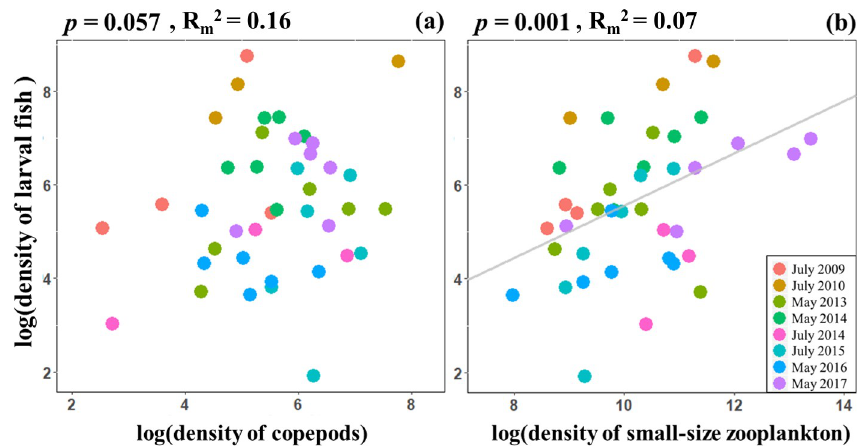
Fig 2. Relationship between prey and larval fish density (ind. m -3 ) at log-log scale. Density of copepods exhibited a positive but not statistically significant relationship with larval fish density (a), whereas small-size zooplankton showed a significant relationship with larval fish density (b). Colors indicate different cruises; grey line in (b) indicates a significant regression from the linear mixed-effects model. P -values and marginal R-squared values are reported.